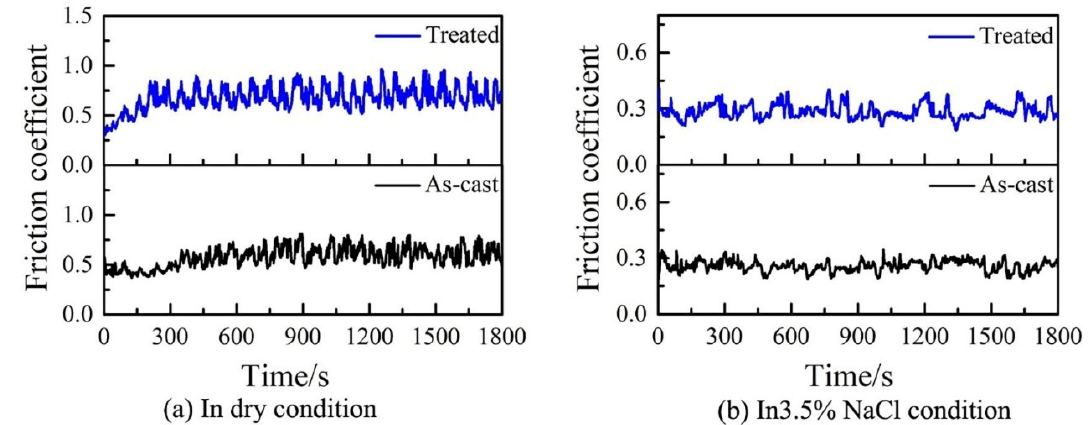
Figure 4. The friction coefficient of as-cast and treated Zr 54.46 Al 9.9 Ni 4.95 Cu 29.7 Pd 0.99 BMGs as a function of sliding time under ( a ) dry and ( b ) 3.5% NaCl solution. function of sliding time under ( a ) dry and ( b ) 3.5% NaCl